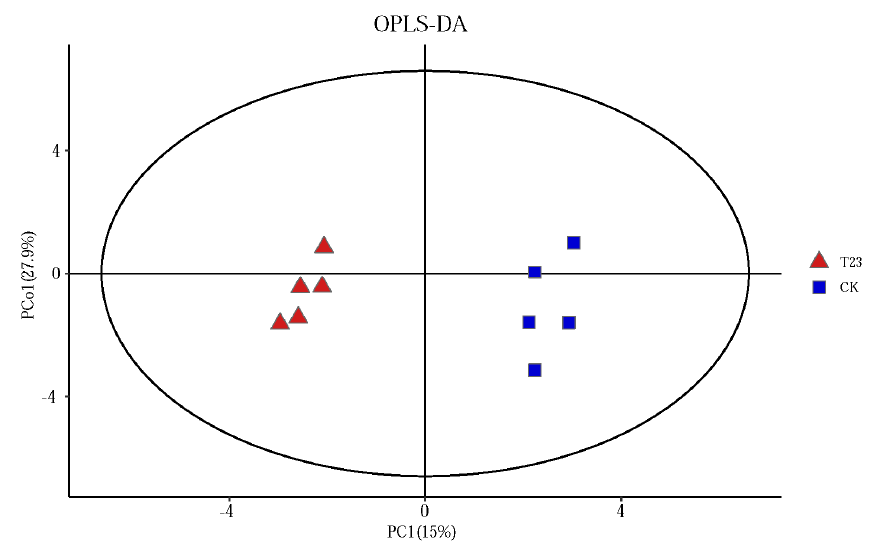
Figure 4. OPLS-DA score map of muskmelon rhizosphere soil after T. viride T23 application. Red triangles represent the T. viride T23 group and blue dots represent the control group.